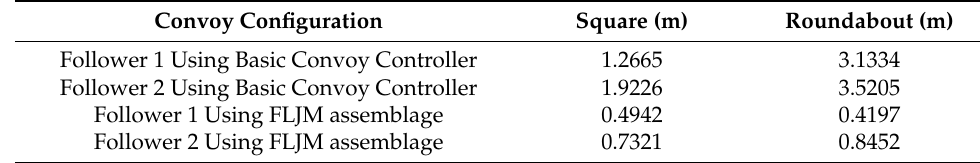
Table 3. Average MAE under a constant jamming attack.